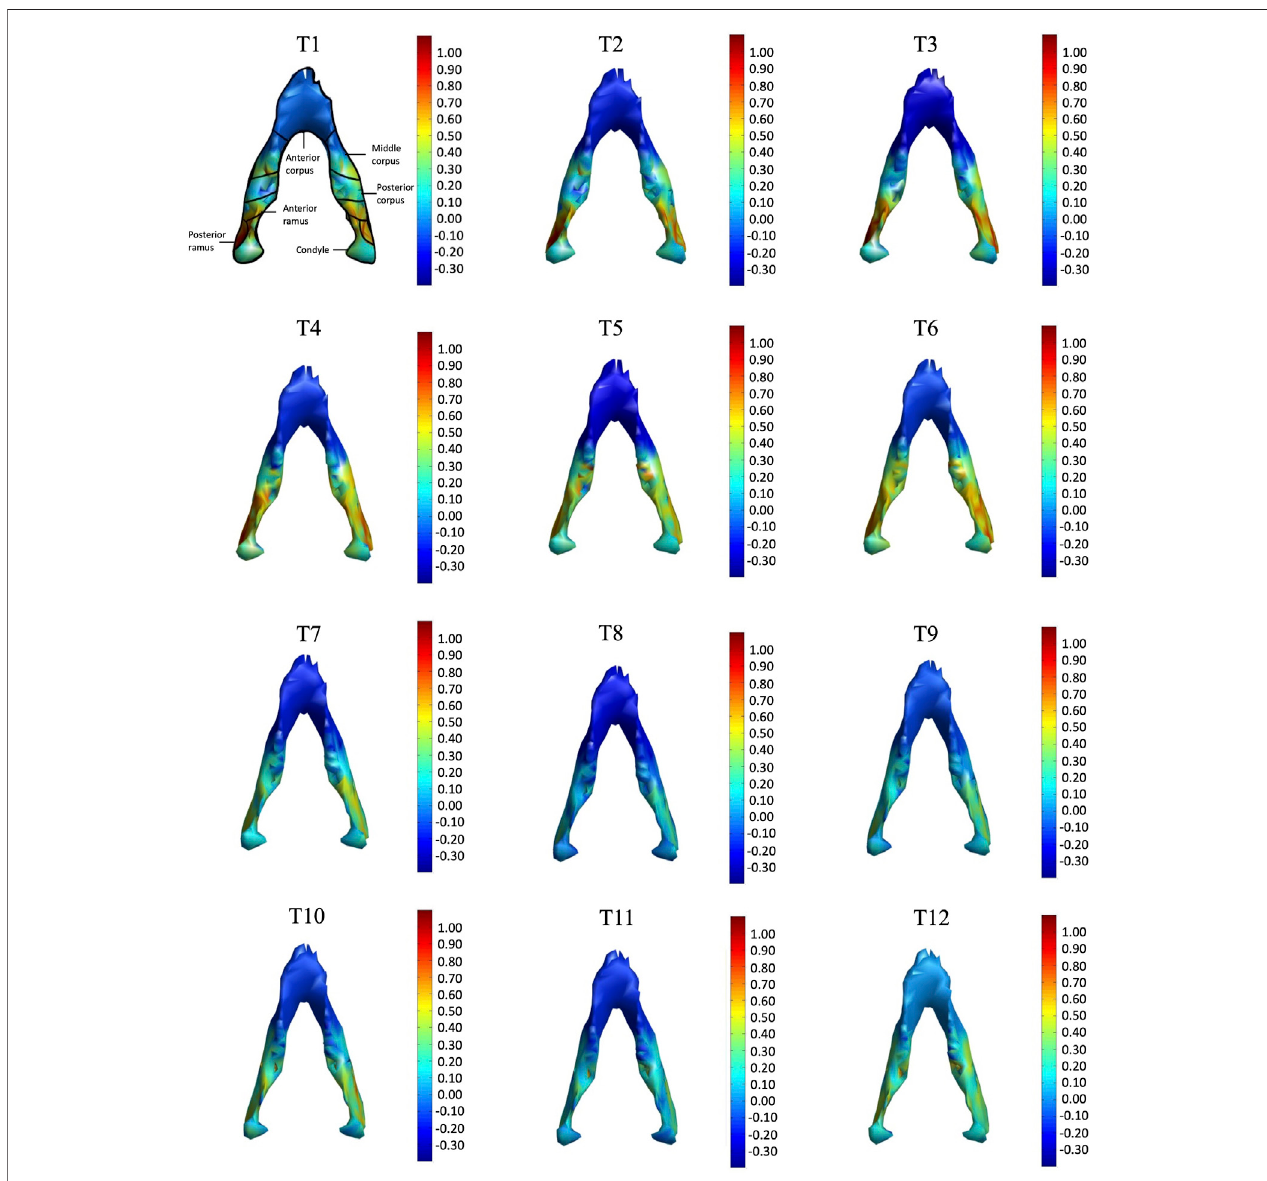
FIGURE 8 | Superior view of the mandible of a typical subject with monthly rates of morphological changes over the mandibular surface as color maps from T1 to T12. The models were scaled to a similar size for better visualization. (unit: %/month).